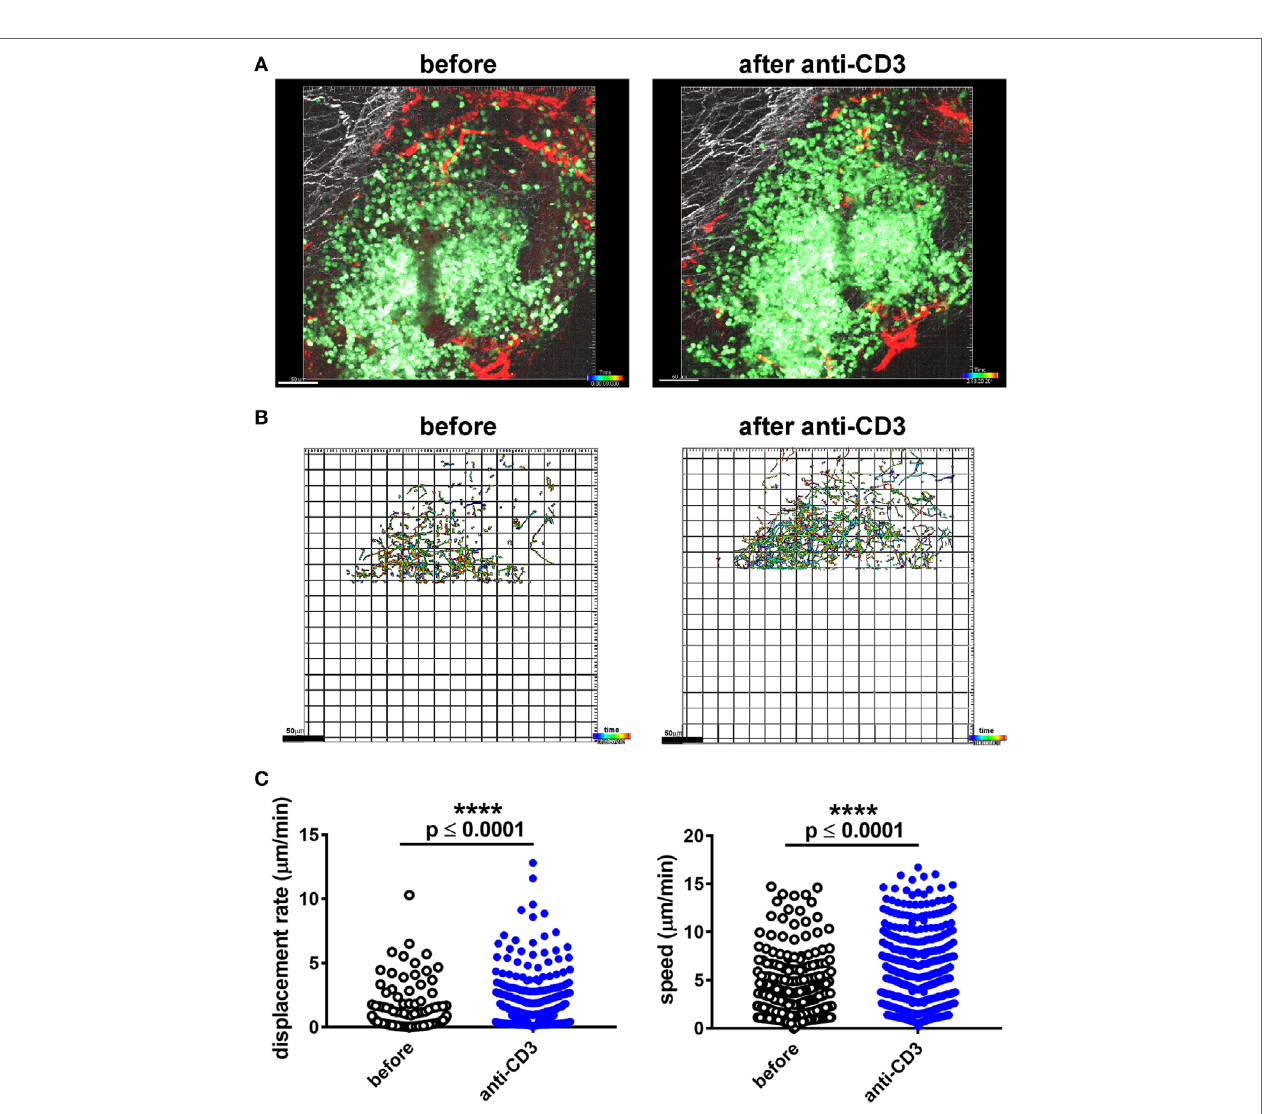
FigUre 3 | Imaging of T cell infiltration in NOD- scid islets transplanted into the pinna of the ear of a CD2-GFP NOD recipient before and after administration of agly anti-CD3. (a) On day 0, islets were isolated from a NOD- scid mouse and grafted into the pinna of a CD2-GFP NOD mouse. On day 7, the graft recipient was anesthetized and the graft imaged using multiphoton microscopy. Then 20 µg of first isotype control antibody and then agly anti-CD3 was administered i.v. and the graft imaged again. (B) Still images from acquired Z-stack longitudinal multiphoton imaging showing islet-infiltrating GFP + T cells (green) moving around a grafted islet in a 12-week-old NOD recipient before injection [ (B) , left panel], after injection of isotype control antibody [ (B) , center panel], and after injection of aglycosyl anti-CD3 [ (B) , right panel]. The white bar represents 50 µm. Red = blood vessels, blue = collagen (secondary harmonic signal), green = GFP. (c) Depiction of the individual tracks of infiltrating cells during the imaging period in the indicated conditions. (D) Plotting of the recorded displacement rate (left) and max speed (right) of islet infiltrating cells before and after administration of isotype antibody or aglycosyl anti-CD3. The data are representative of five independent experiments and differences between groups were analyzed using a non-parametric Kruskal–Wallis test with a Dunn’s post-test for multiple comparisons. (e) Section staining of pinnae [ (e) , top panels] and pancreas [ (e) , bottom panels] from isotype control injected graft recipients [ (e) , left-hand panels] and aglycosyl anti-CD3 injected [ (e) , middle panels] or control pinna (top right panel). Red = insulin, blue = DAPI, green =